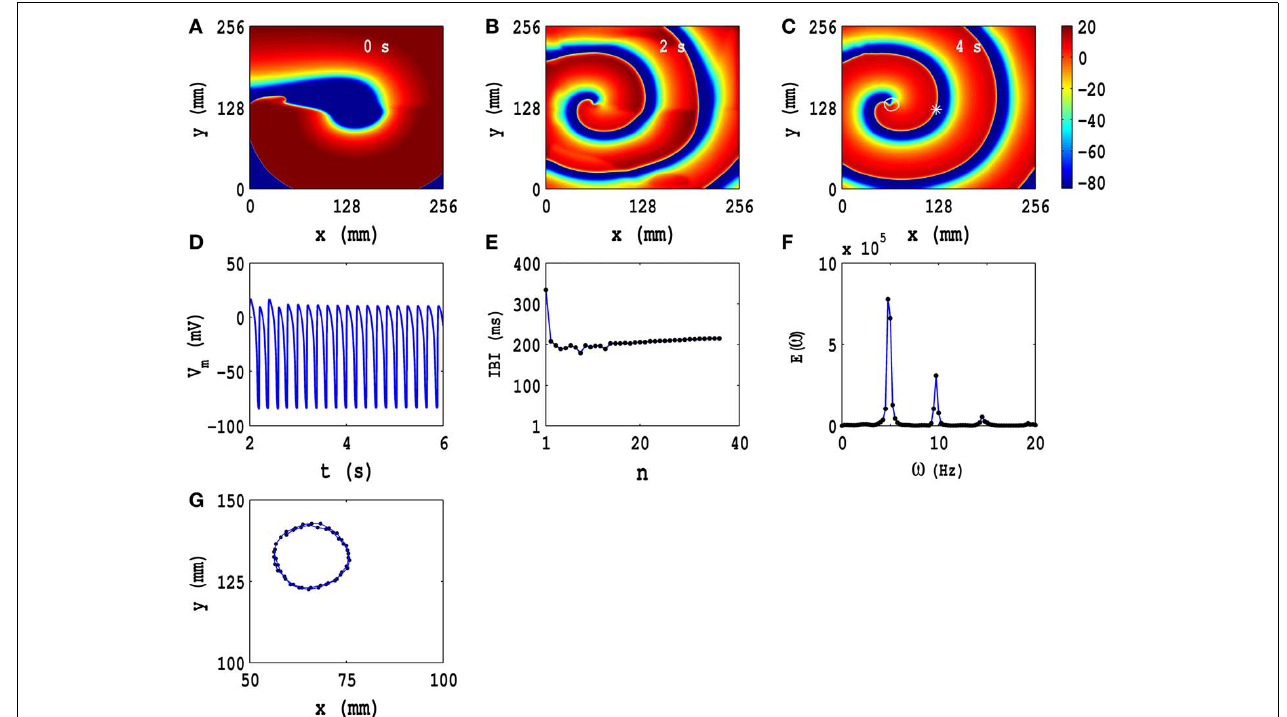
FIGURE 3 | Spatiotemporal evolution of V m for the initial condition IC 1 for the TP06 model in the absence of PD. (A–C) Pseudocolor plots of V m at times t = 0s, t = 2s, and t = 4s, respectively, showing the evolution toward a state with a rotating spiral (RS); the animation (A) in Video S2 shows the spatiotemporal evolution of V m for this case. (D) The local time series of V m ( x , y , t ), from the representative point ( x = 125mm, y = 125mm) (the asterisk in (C) ) for 2s ≤ t ≤ 6s; (E) a plot of the IBI, which we obtain